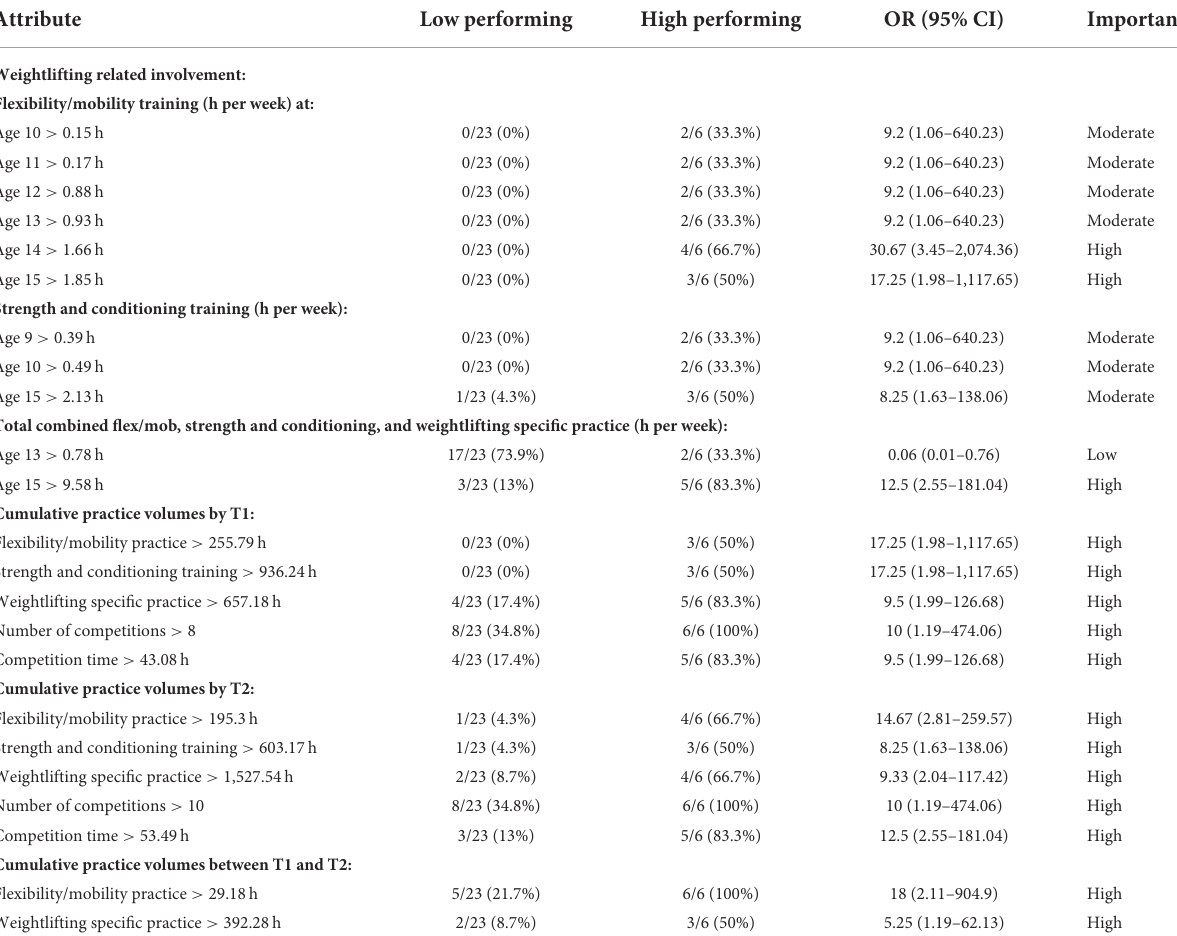
TABLE 7 Logical attributes for all discriminative features within sport participation through development. Attribute Low performing High performing OR (95% CI)